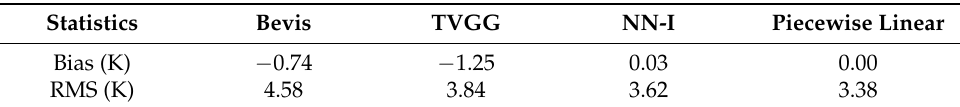
Table 2. Statistics of the T m estimates for different